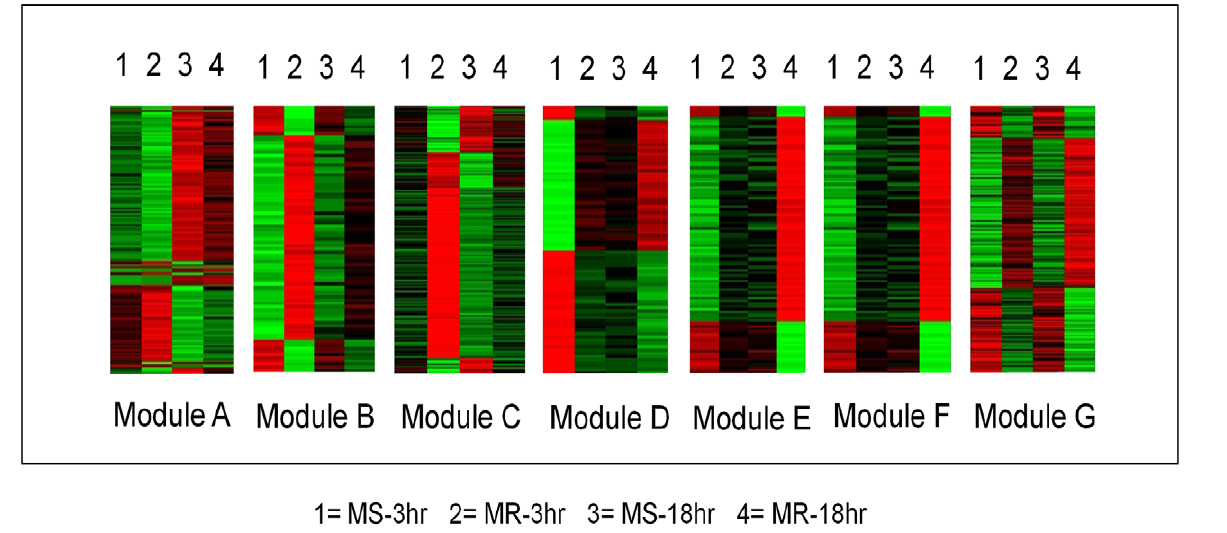
Figure 2. Heat maps of gene expression in the modules. Each row represents a gene in the module. The module IDs are indicated. The columns in the heat maps are labeled to indicate the mosquito strain and the time point to which the gene expression belongs to. The red color indicates up-regulation and green indicates down-regulation of gene expression.